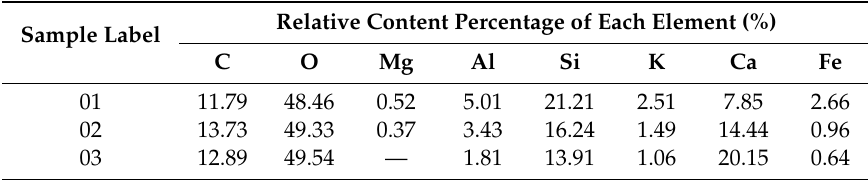
Table 1. Relative content percentage of elements in the rock